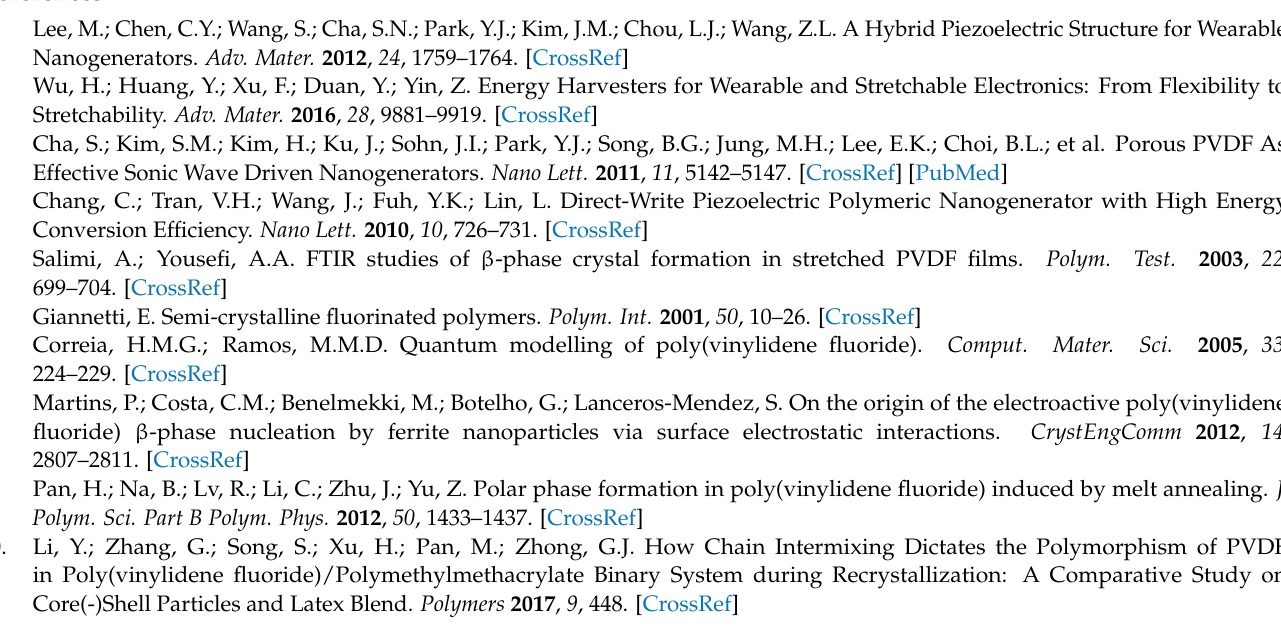
Figure S2: FTIR spectra of biaxial stretching PVDF/PMMA blend films with varied compositions (from VM15 to VM30) and stretch ratios at the locations of (a) c, (b) p1, (c) p2, (d) d1 and (e) d2. The results for stretching ratios of 2 × 2, 2.5 × 2.5, 3 × 3 are shown in (x − 1), (x − 2), and (x − 3), Figure S3: XRD patterns of biaxial stretching PVDF/PMMA blend films with varied compositions (from VM15 to VM30) and stretch ratios at the locations of (f) c, (g) p1, (h) p2, (i) d1 and (j) d2. The results for stretching ratios of 2 × 2, 2.5 × 2.5, 3 × 3 are shown in (x − 1), (x − 2), and (x − 3), Table S1: Material parameters of PVDF and